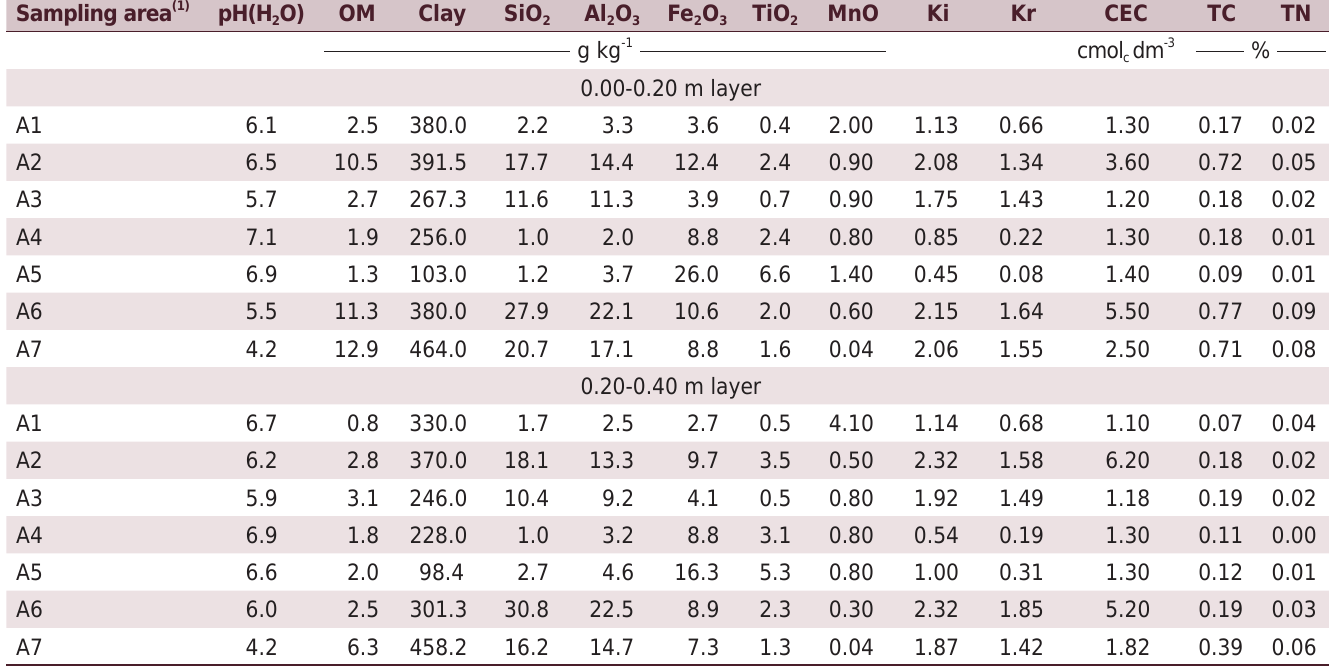
Table 1. Chemical properties of soils and sediments for the 0.00-0.20 and 0.20-0.40 m layers from Serra Pelada Sampling area